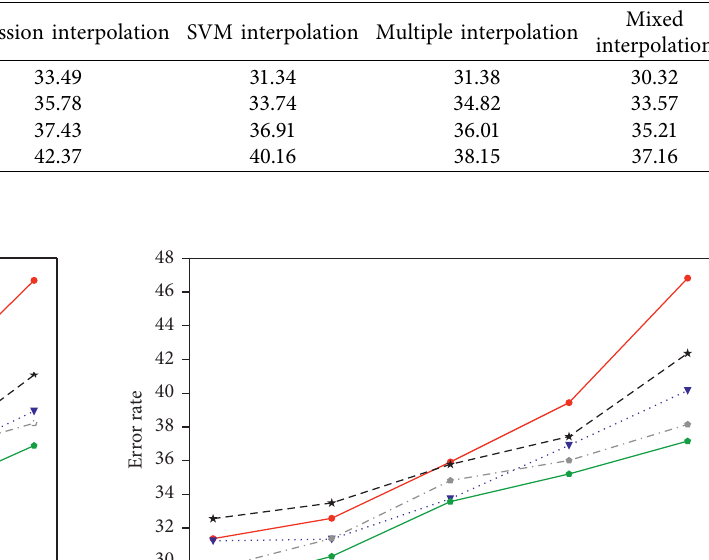
Table 5: Error rates of interpolation results of five interpolation methods under different data miss rates.